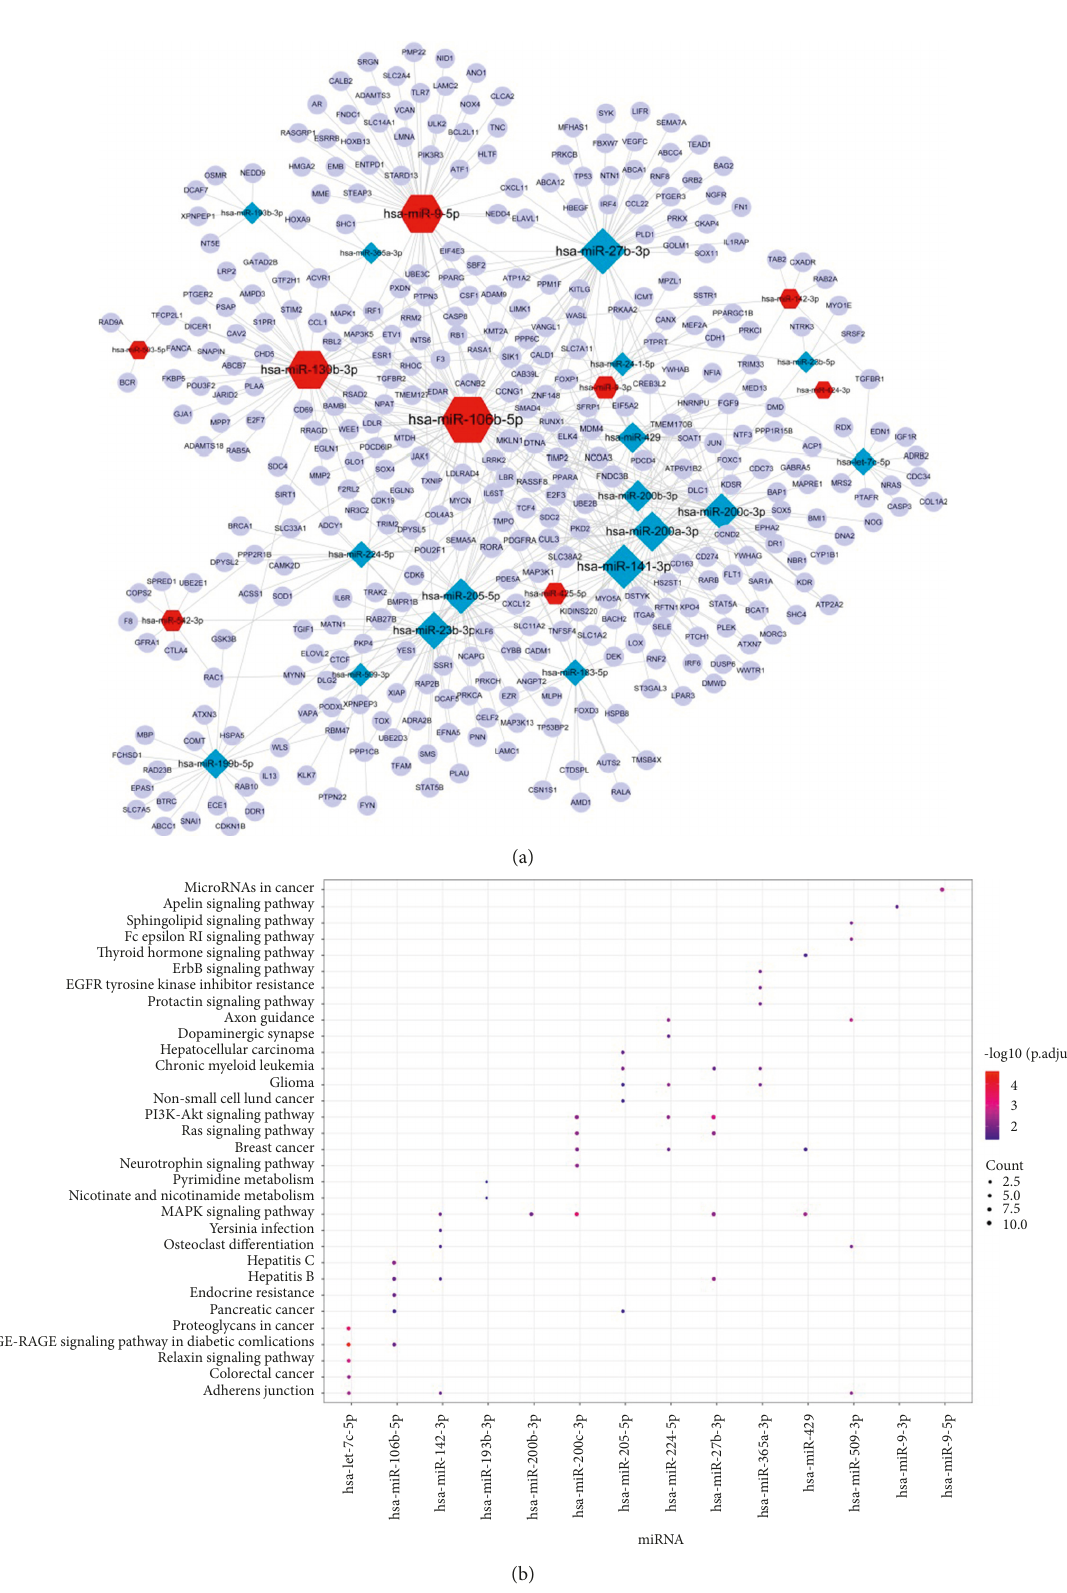
Figure 3: Prediction of target genes of miRNA and enrichment analysis. (a) The miRNA-gene network. (b) The results of the Kyoto Encyclopedia of Genes and Genomes (KEGG) pathway enrichment analysis. The size of the ball represents the number of genes enriched in each term. The color of the ball represents the P